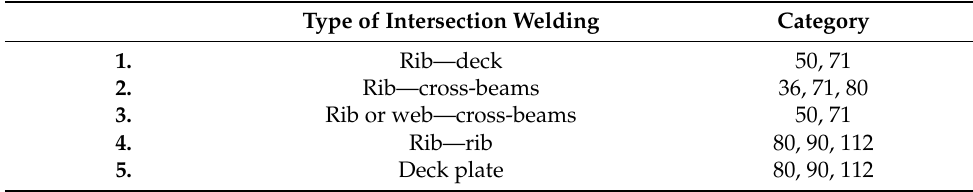
Figure 7. Table 8.8 UNI EN 1993-1-9—Construction details of closed rib in orthotropic plates (1/2) [53]. Table 1. Detailed categories according to the Eurocode